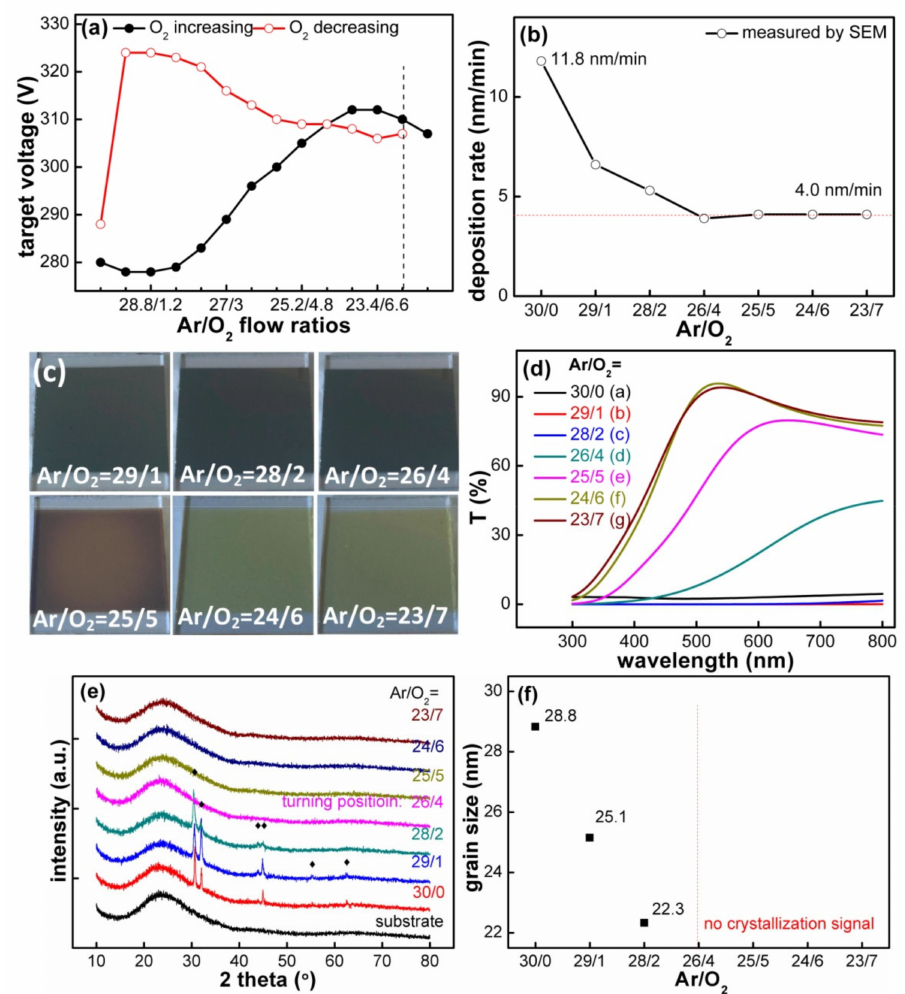
Figure 1. ( a ) Voltage hysteresis curve, ( b ) deposition rate, ( c ) optical images, ( d ) transmittance curves, ( e ) XRD patterns and ( f ) average grain size of the SnO x films deposited with various Ar/O 2 flow